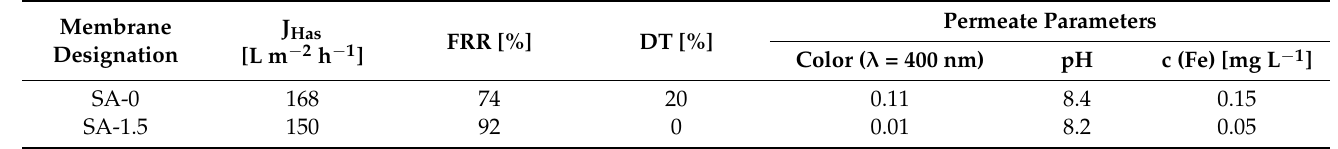
Table 5. Membrane performance and permeate parameters of reference PSF/Synperonic F108 and modified PSF/Synperonic F108/PAA membranes.